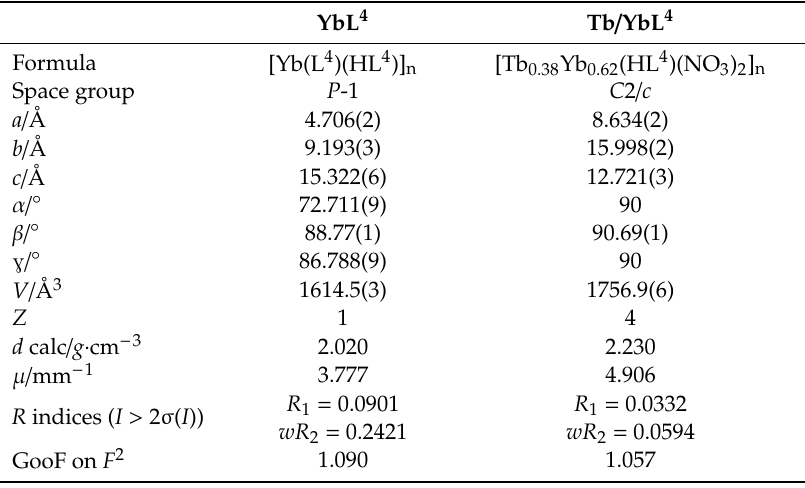
Table 3. Crystal and refinement data for YbL 4 and Tb / YbL 4